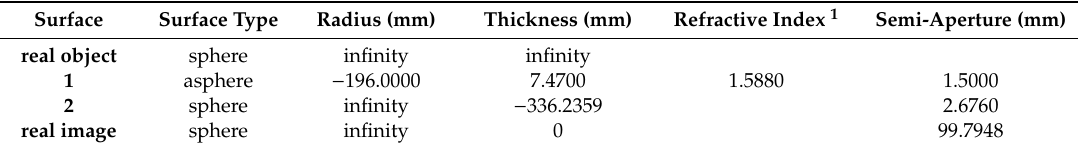
Table 3. Optical surfaces used in the simulation of the real image.